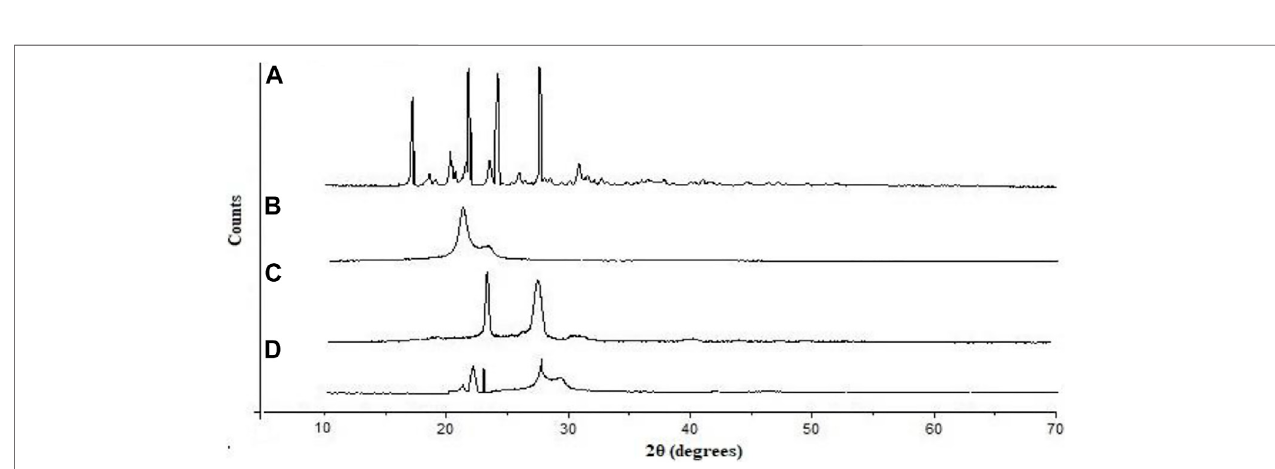
was merely observed at angles of 21.1 and 23.3 of 20 diffractions.